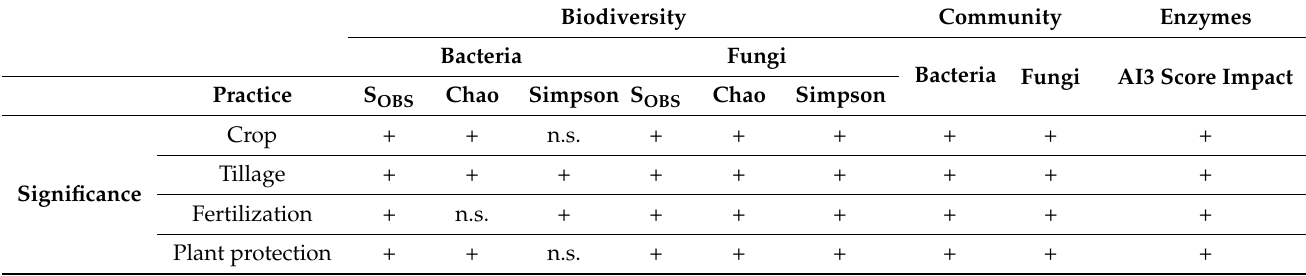
Table 4. Summary of the significance of the impact that practices have on biodiversity, community structure clustering, and soil alteration (+ indicates significance of at least p < 0.05, n.s.: not